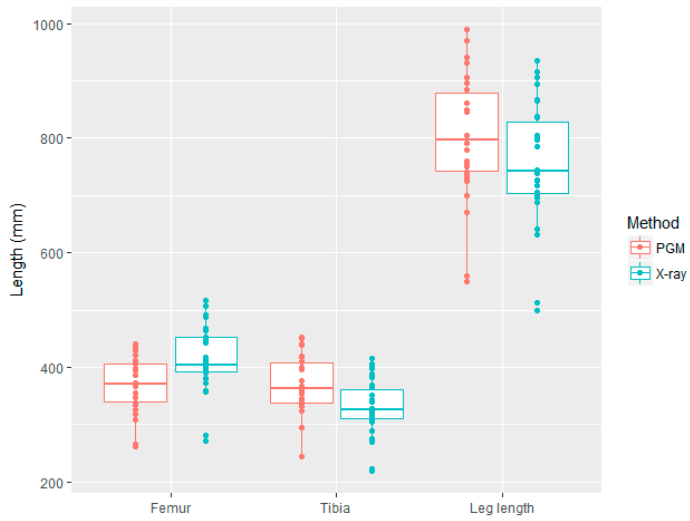
Figure 3. Differences in the median, quartiles, extreme values and outlier subjects for segmental and leg length measured by PGM and X-ray.